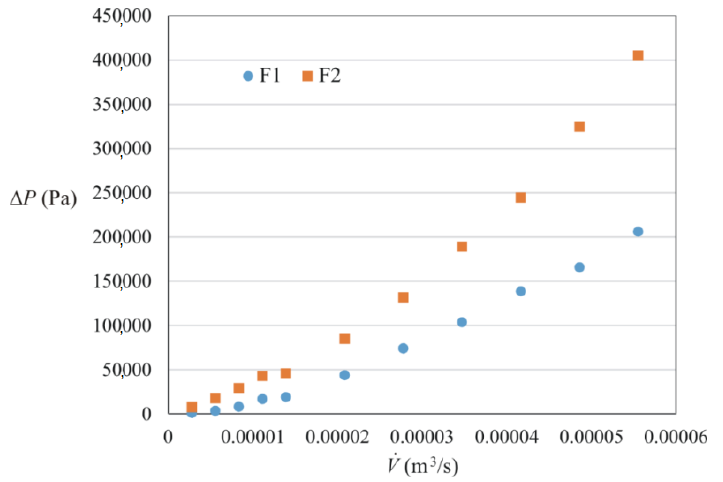
Figure 4. Dependence of pressure drop on the volumetric flow rate for the tested filters: F1—plastic filter, F2—ceramic filter.